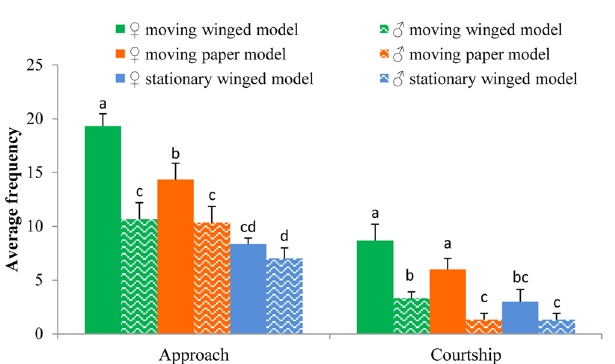
Figure 2. The average number of males approaching and courting moving and stationary winged and paper models. Different letters above bars indicate significantly different at P < 0.05 significance